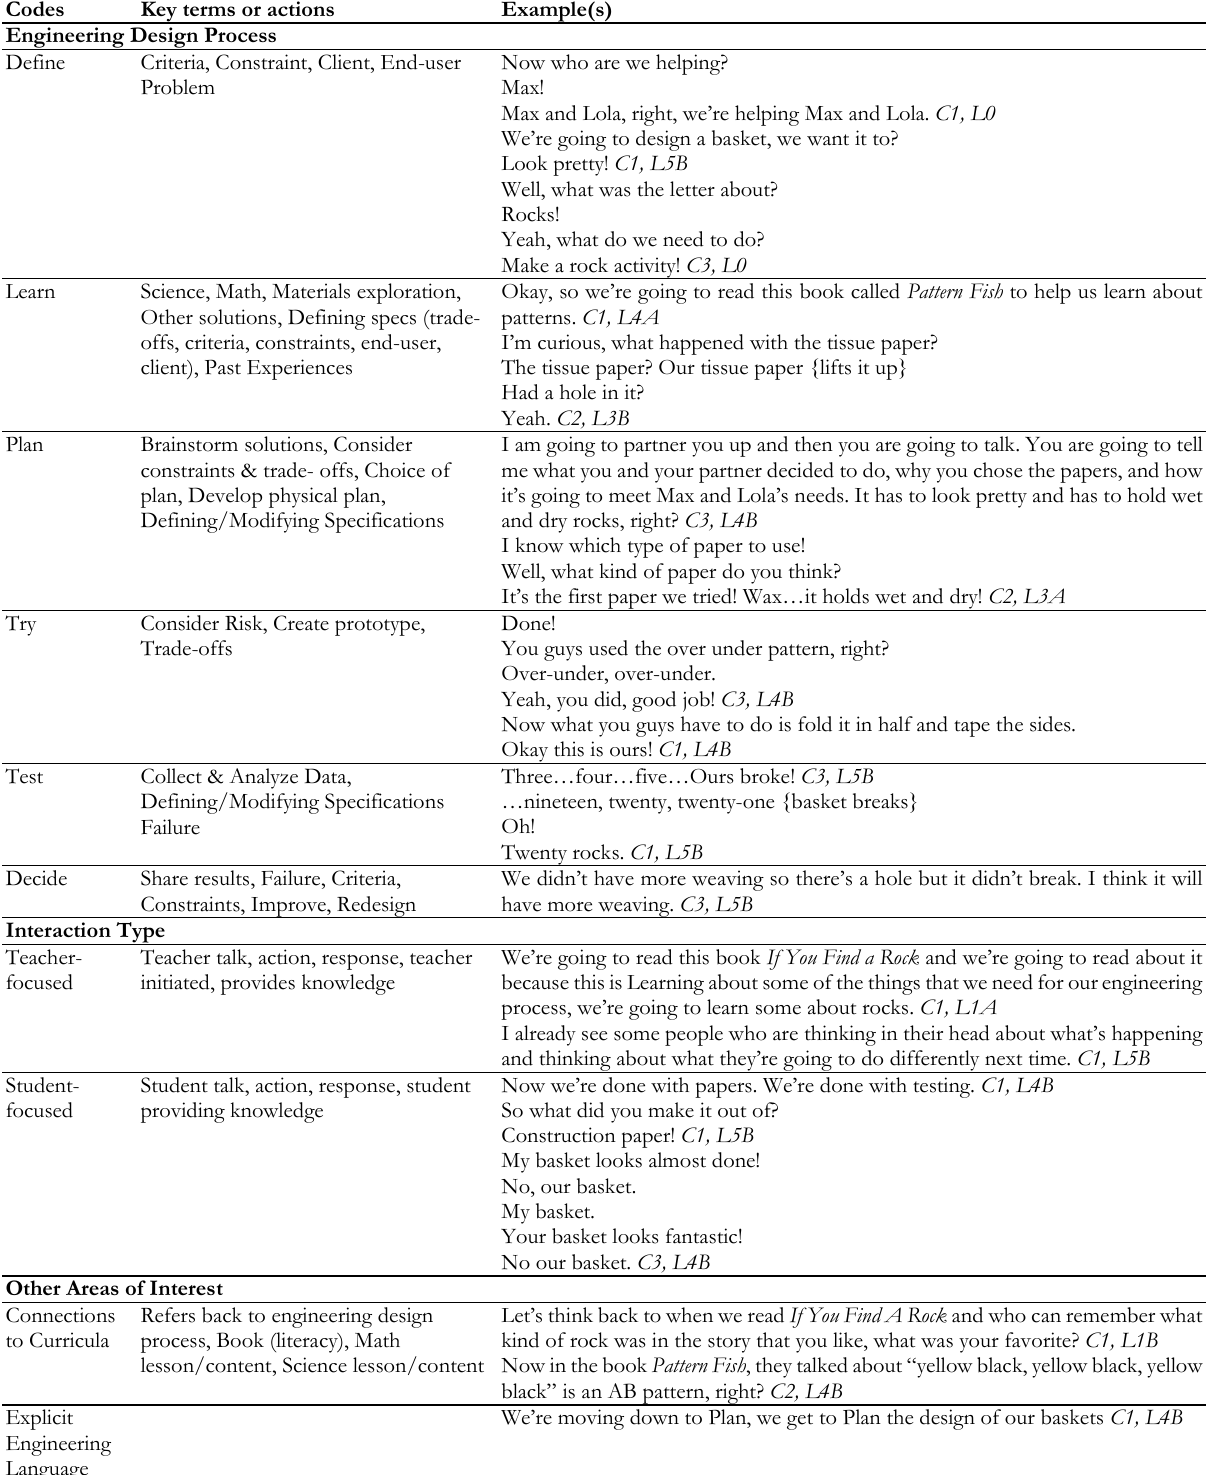
Table 2. Final coding scheme and representative examples